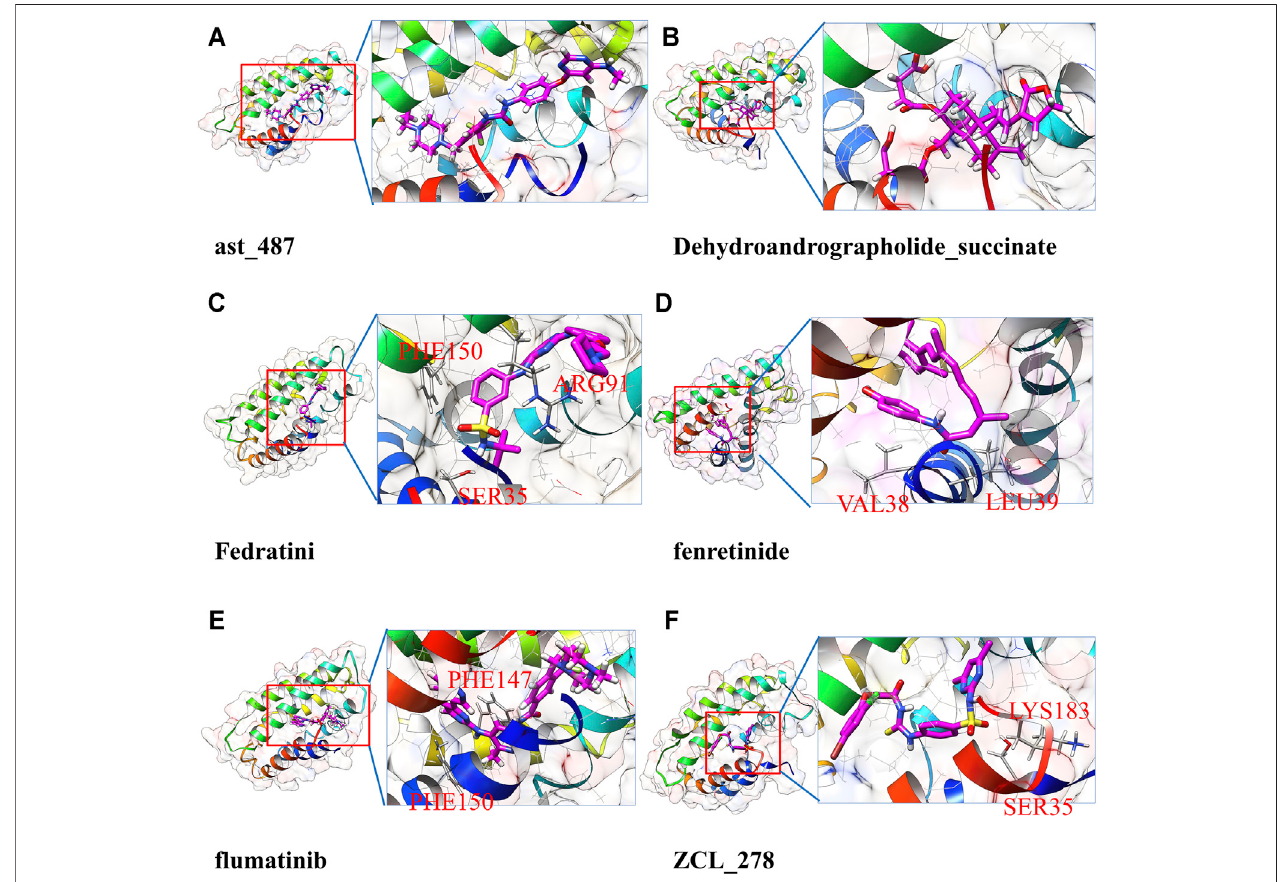
FIGURE 5 | Detailed atomic interaction between TIPE2 and six representative ligands of candidate ’ s list 2 in the last frame of MD simulation.